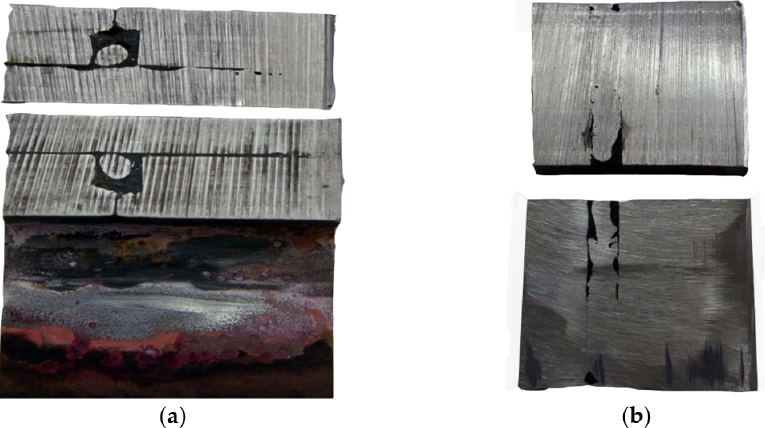
Figure 17. The extensiveness of the inclusion analyzed with the use of macroscopic examination (handy-size bulk carrier 30206 DWT): ( a ) surfaces created by the cut shown in Figure 11 and ( b ) metallurgical inclusion running parallel to the surface of part